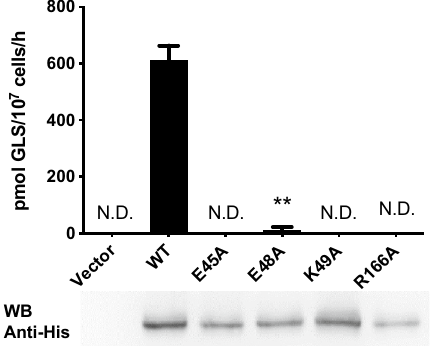
Figure 5. EXXEK and Arg166 are involved in the transport function of AtGTR1. The GLS transport activity of AtGTR1 mutants. The GLS transport activity was determined by yeast uptake assay, and the protein expression of these mutants was confirmed by western blot. The primary antibody is an anti-His-tag antibody. Bar values with error bar represent mean ± S.D. (n = 3); ** p < 0.01; N.D. indicates